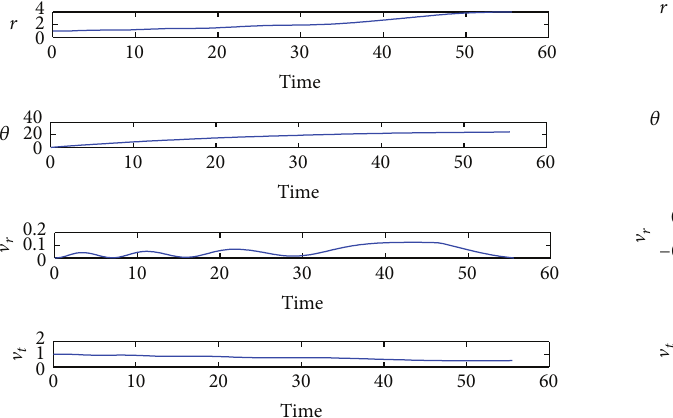
Figure 16: Time history of state